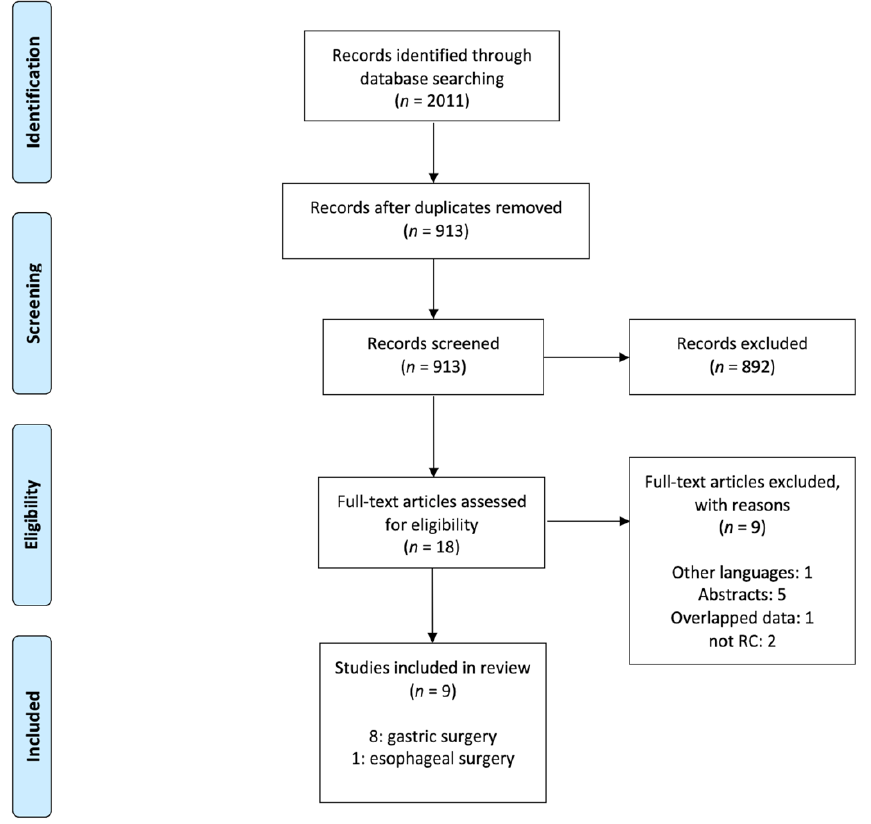
Figure 1. PRISMA flow diagram.